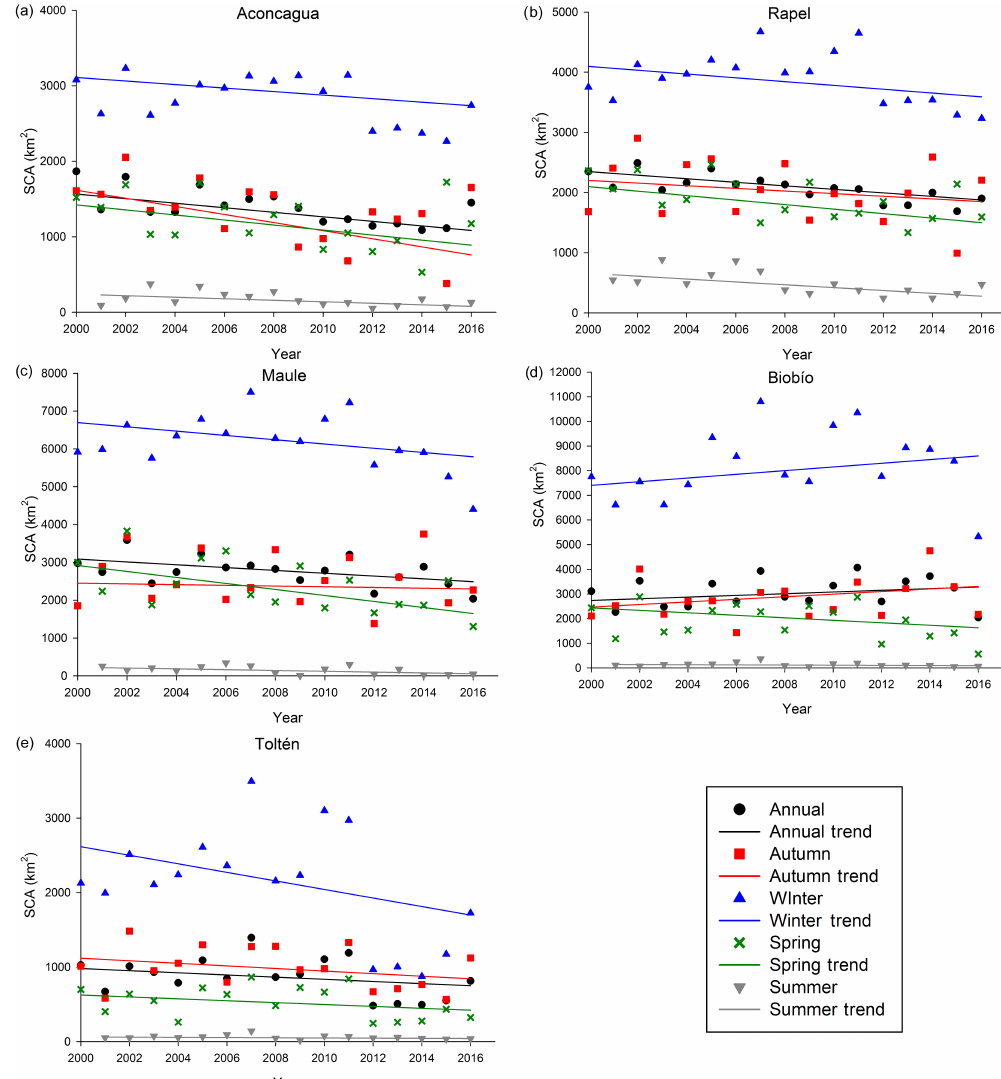
Figure 8. Annual and seasonal trends of SCA at Aconcagua, Rapel, Maule, Biobío and Toltén